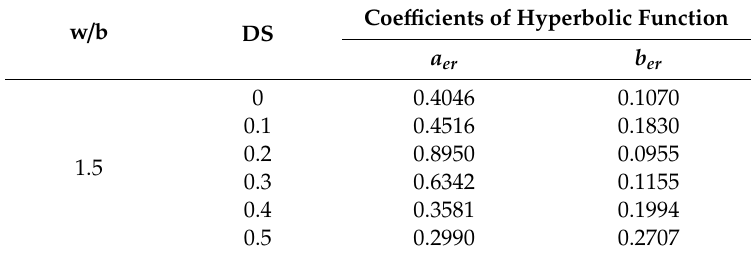
Figure 14. The relationship of the compressive strength and surface resistivity with various DS contents. Table 6. Characteristics of the coefficients 𝑎 𝑒𝑟 and 𝑏 𝑒𝑟 of the relationship prediction model between the compressive strength and electrical resistivity versus the DS contents.